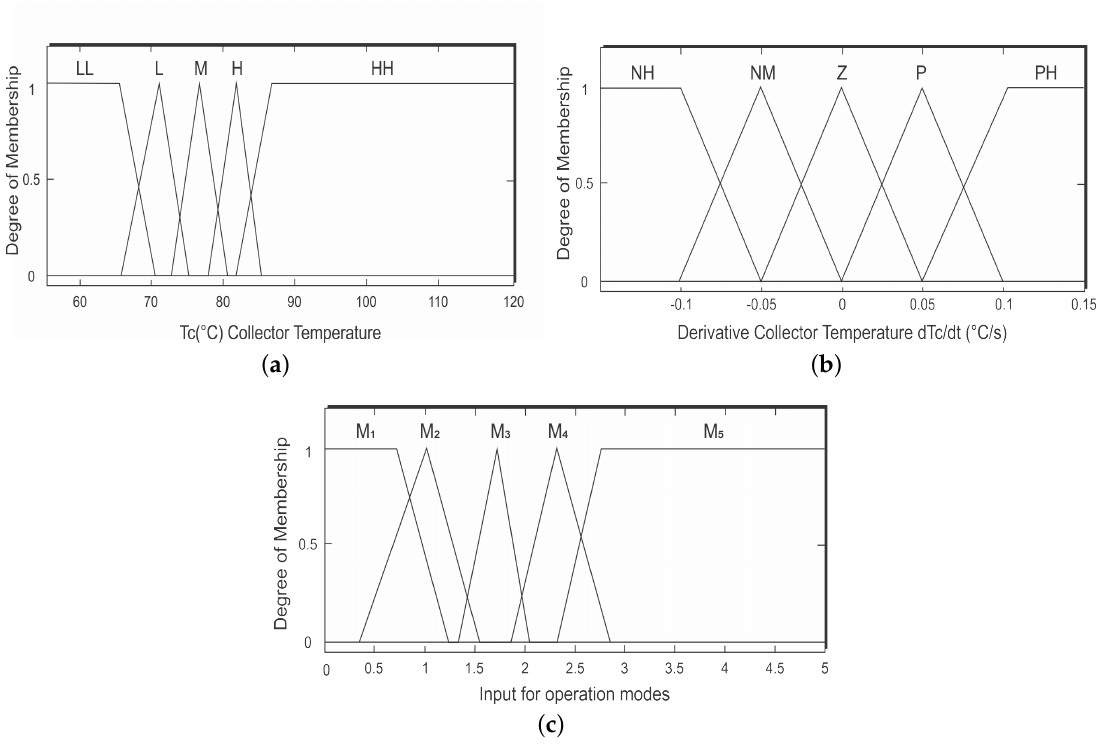
Figure 11. Fuzzy input variables for supervisory control. ( a ) Input for collector temperature; ( b ) input for derivative collector temperature; ( c ) operation modes. LL, Low Low; HH, High High; Z, Zero; NM, Medium Negative.